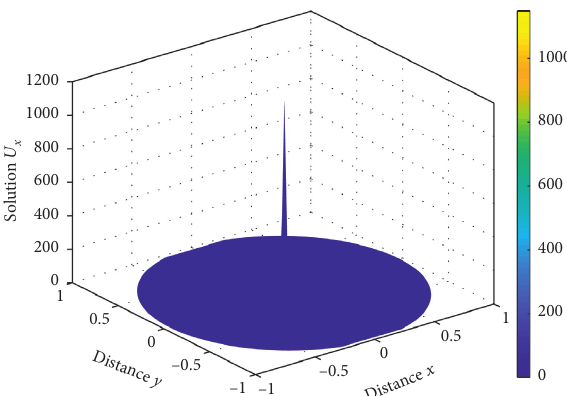
Figure 17: The exact solution at t � 0.01, with D � − 0.25, ε � 0 . 01, ( t,. )) � 710. max ( u ex